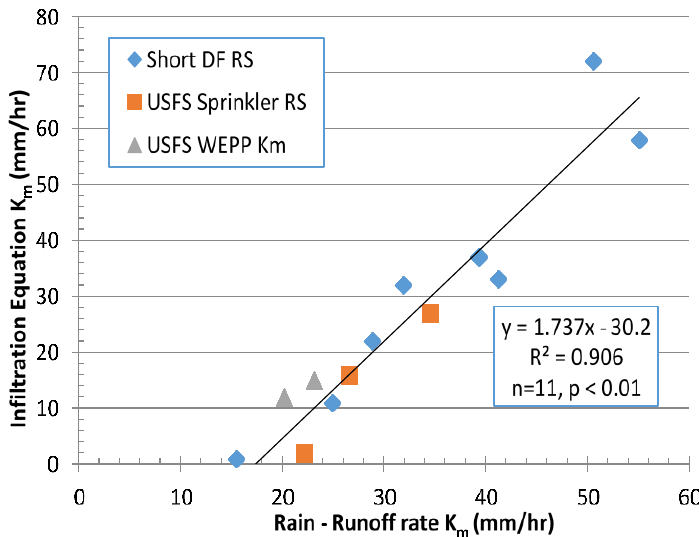
Figure 12. Dependence of Infiltration equation K m values on Rainfall-Runoff rates for the short DF and Sprinkler type RSs from tests plots at Ward Creek and Round Hill forest landings.